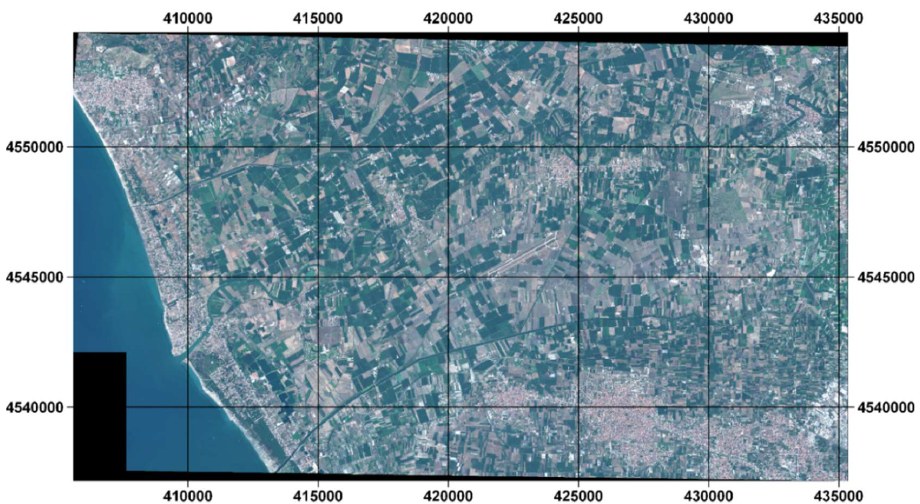
Figure 5. The RGB composition of the GeoEye-1 satellite imagery.